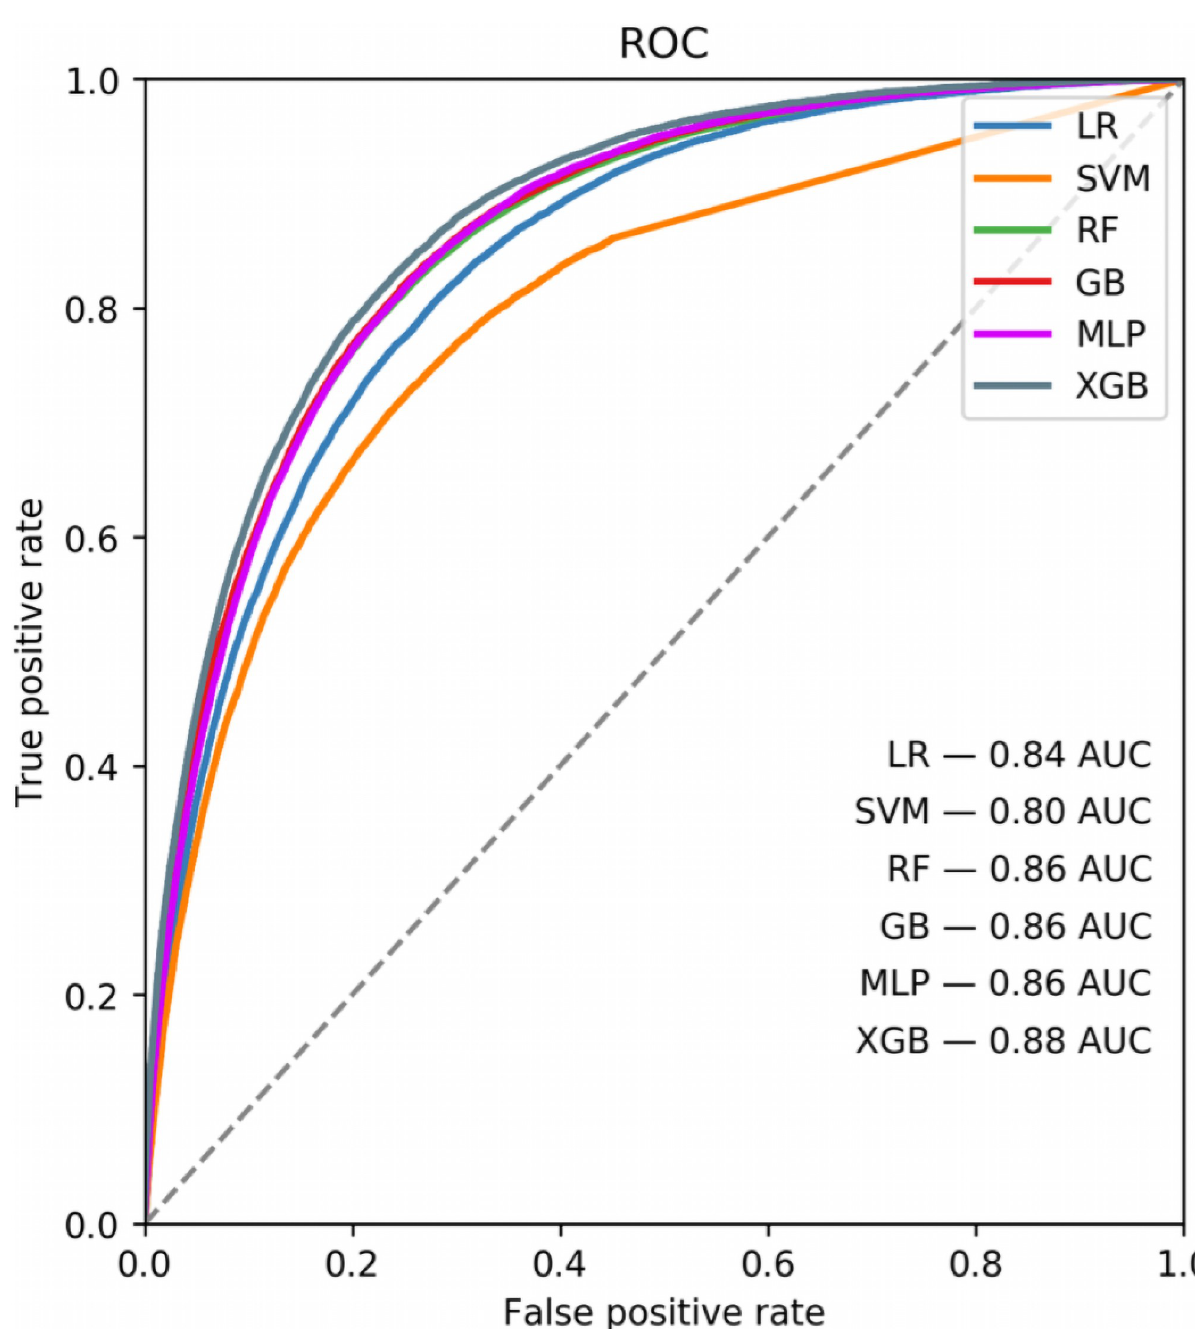
Fig 1. Algorithm performance comparisons for predicting 30-day mortality. Model area under the curve (AUC) comparisons for 30-day mortality. Abbreviations: Logistic regression (LR), supported vector machine (SVM), random forest (RF), multilayer perceptron (MLP), extreme gradient boosted tree